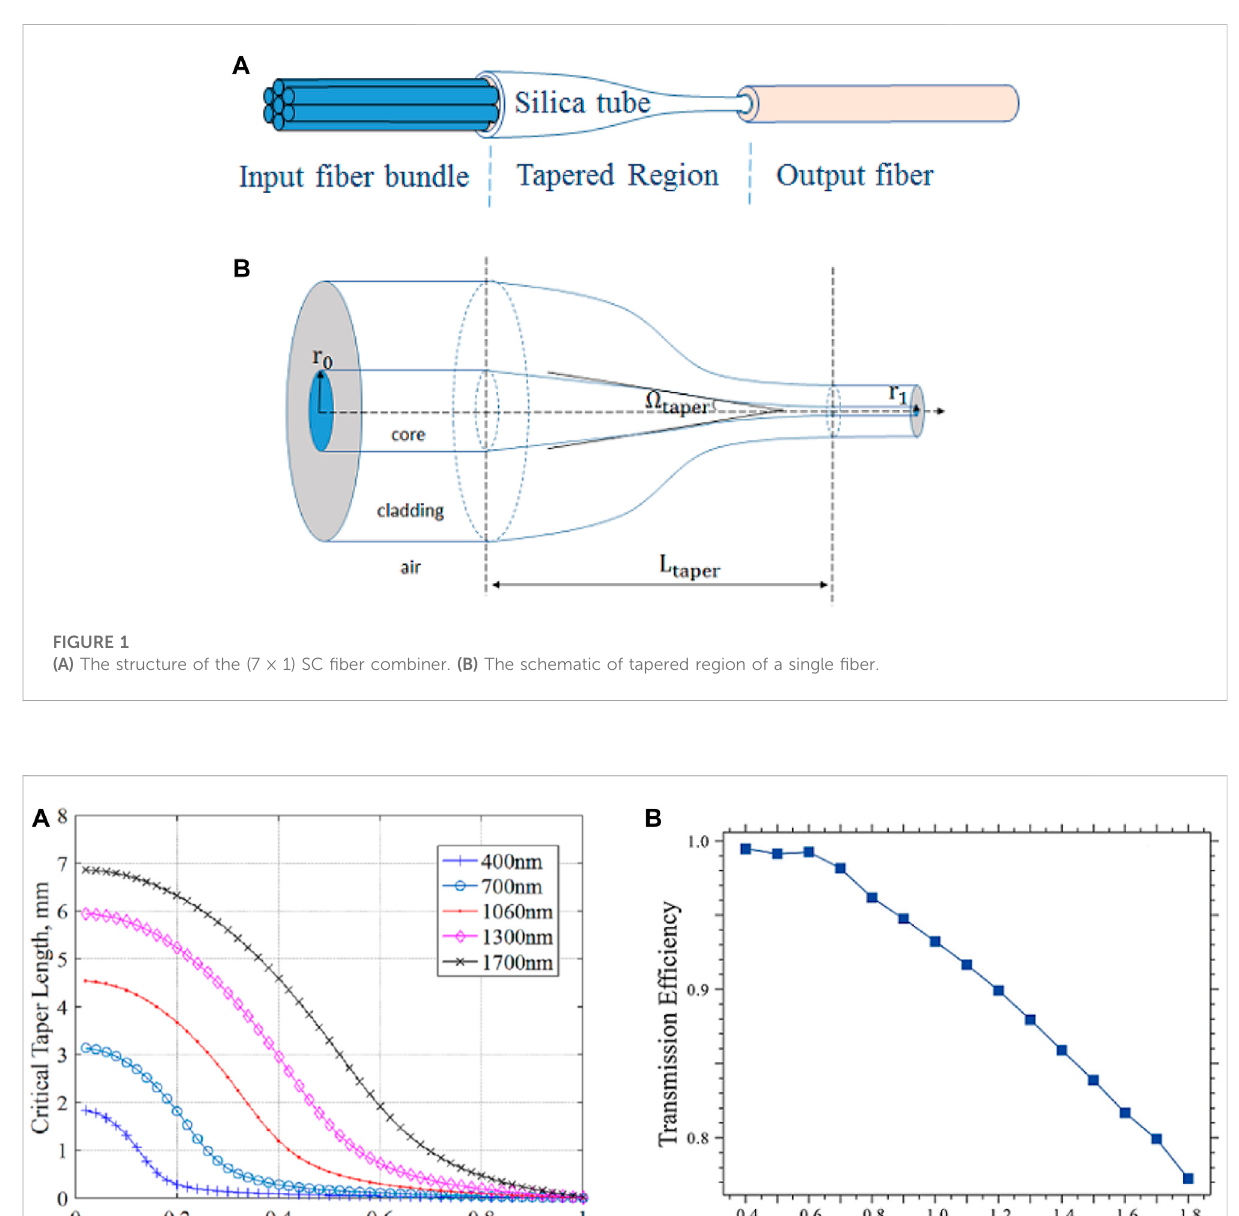
transmission loss of fi ber combiner mainly comes from the tapered region of input fi ber bundle. The tapered region structure of a single fi ber is shown in Figure 1B, where Ω taper is the tapered angle, L taper is the tapered region length corresponding to Ω taper , r 0 is the initial core radius, and r 1 is the tapered core radius. The taper ratio is de fi ned as TR ,